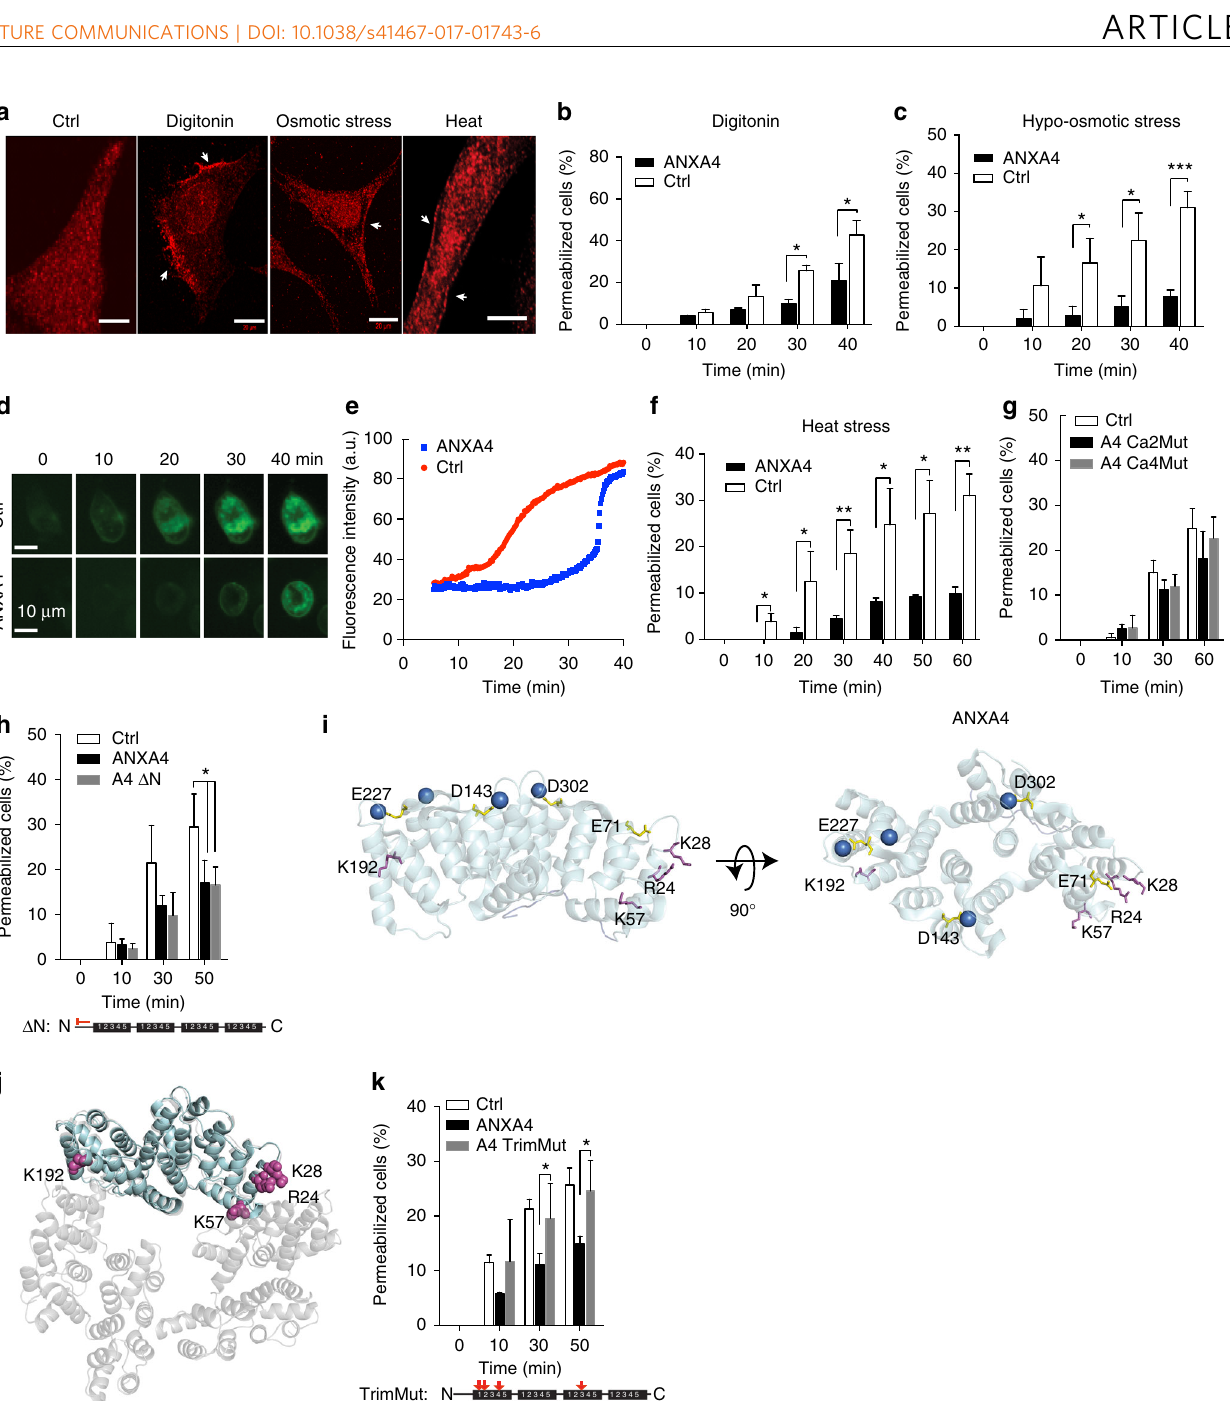
NATURE COMMUNICATIONS | 8: